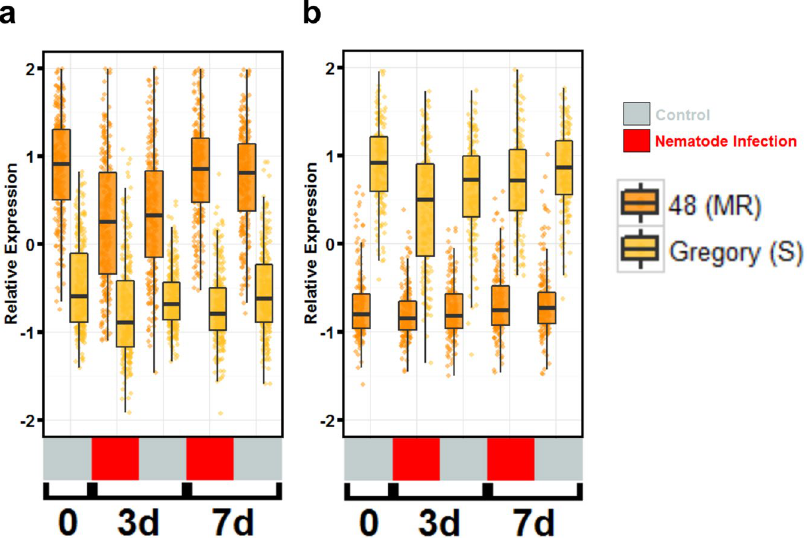
Figure 5. Differentially expressed genes affected by genotype between RIL 48 (MR) and Gregory (S). ( a ) Genes constitutively more highly expressed in line 48 compared to Gregory and ( b ) genes constitutively lower expressed in line 48 compared to Gregory. Boxplots represent median relative expression, first quartile (bottom of box), third quartile (top of box), and maxima. The actual spread of the data is represented by jittered dots so the relative expression of every individual gene is represented on the plot. Uninoculated control (silver) samples and samples inoculated with 20,000 juvenile Meloidogyne arenaria (red) and harvested at 3 days (3d) or 7 days (7d) after